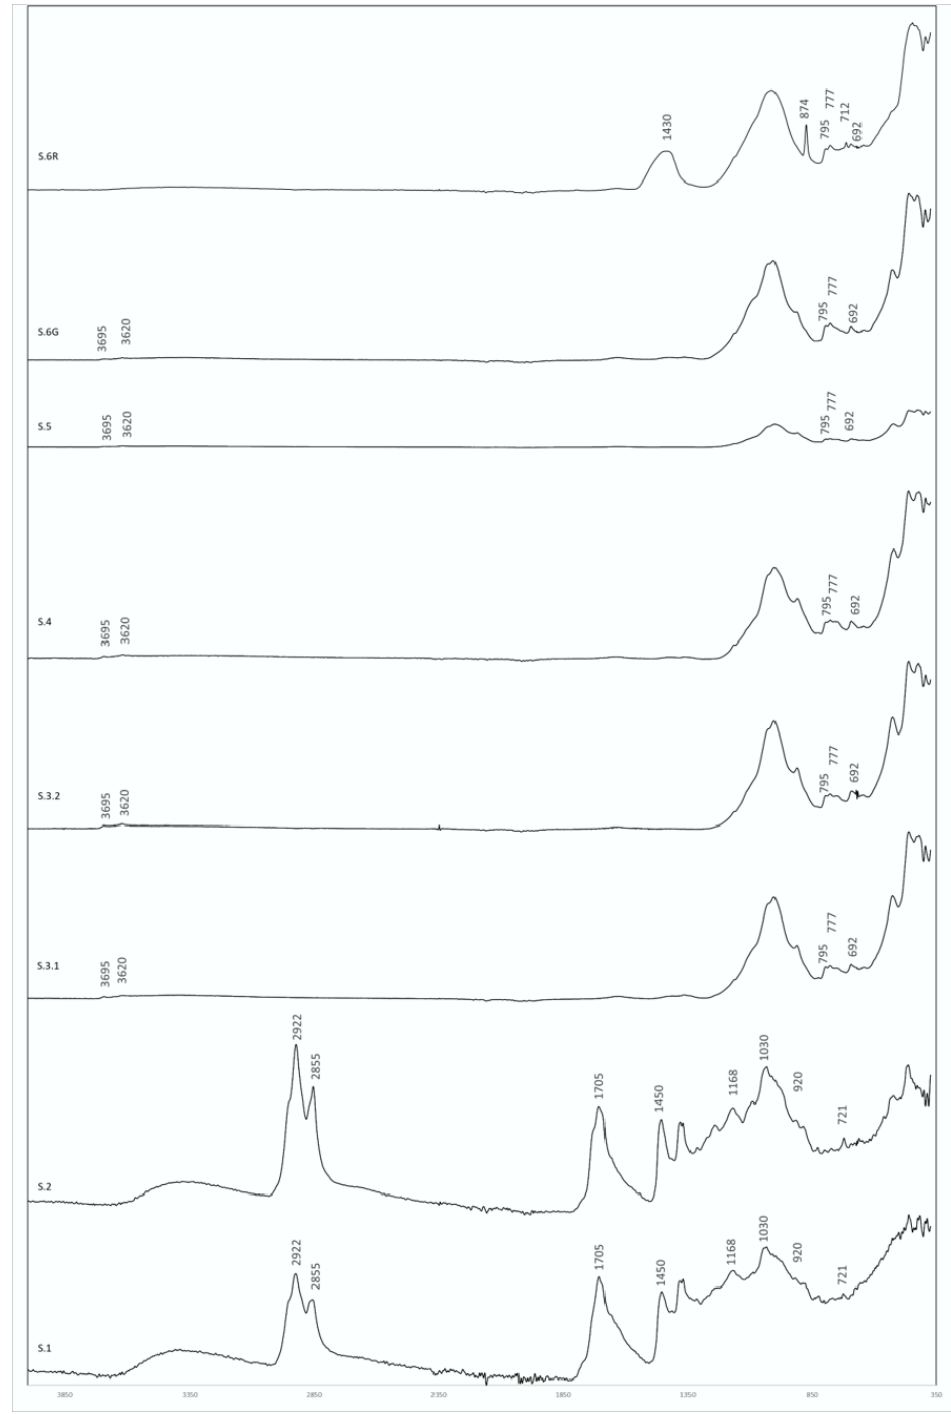
Figure 5. ATR-FTIR spectra of the bulk mortar samples, absorbance vs. wavenumber (cm − 1